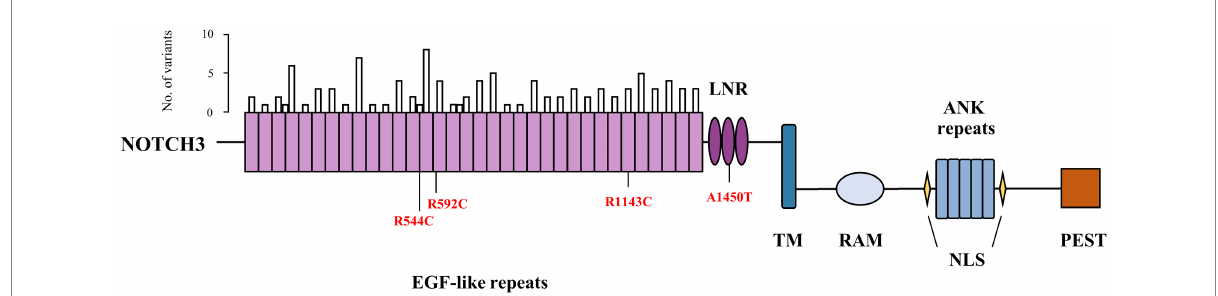
FIGURE 1 Schematic diagram of domain structure and rare variants of NOTCH3 . The bar above represented number of rare variants within epidermal growth factor-like repeat domain. Previously reported variants were depicted as red. EGF, epidermal growth factor; LNR, Lin12-Notch repeats; TM, transmembrane domain; RAM, RBP-j κ -associated molecule domain; ANK, ankyrin; NLS, nuclear localization sequence; PEST, domain rich in proline, glutamate, serine and threonine.